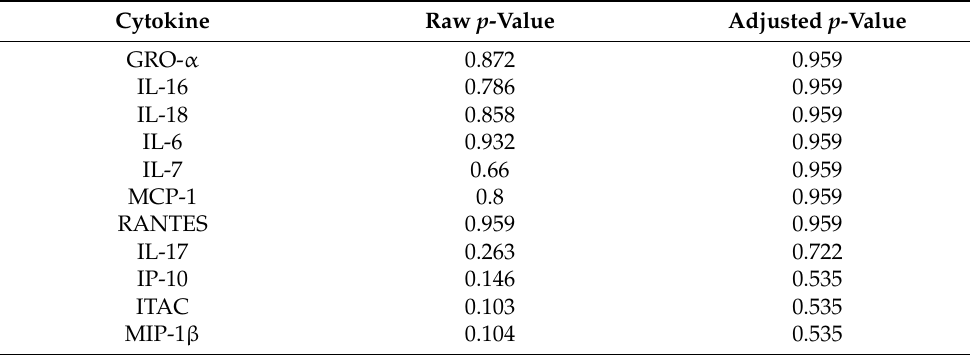
Table 6. Results from Wilcoxon rank-sum test: CMV shedders versus